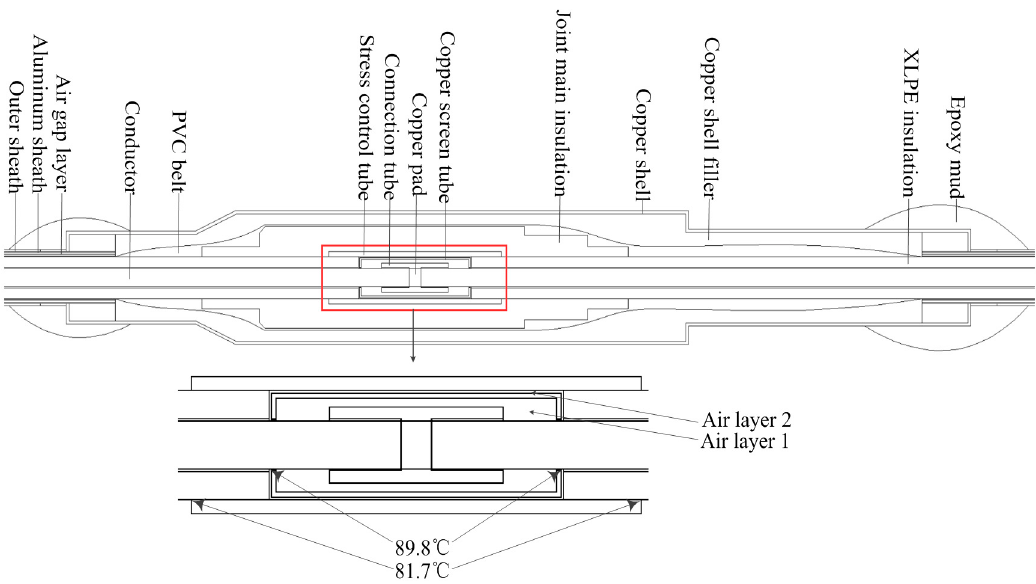
Figure 5. Conductor temperature distribution of the cable joint and nearby cable body (the axis origin is the geometric center of the connecting tube in the cable joint).